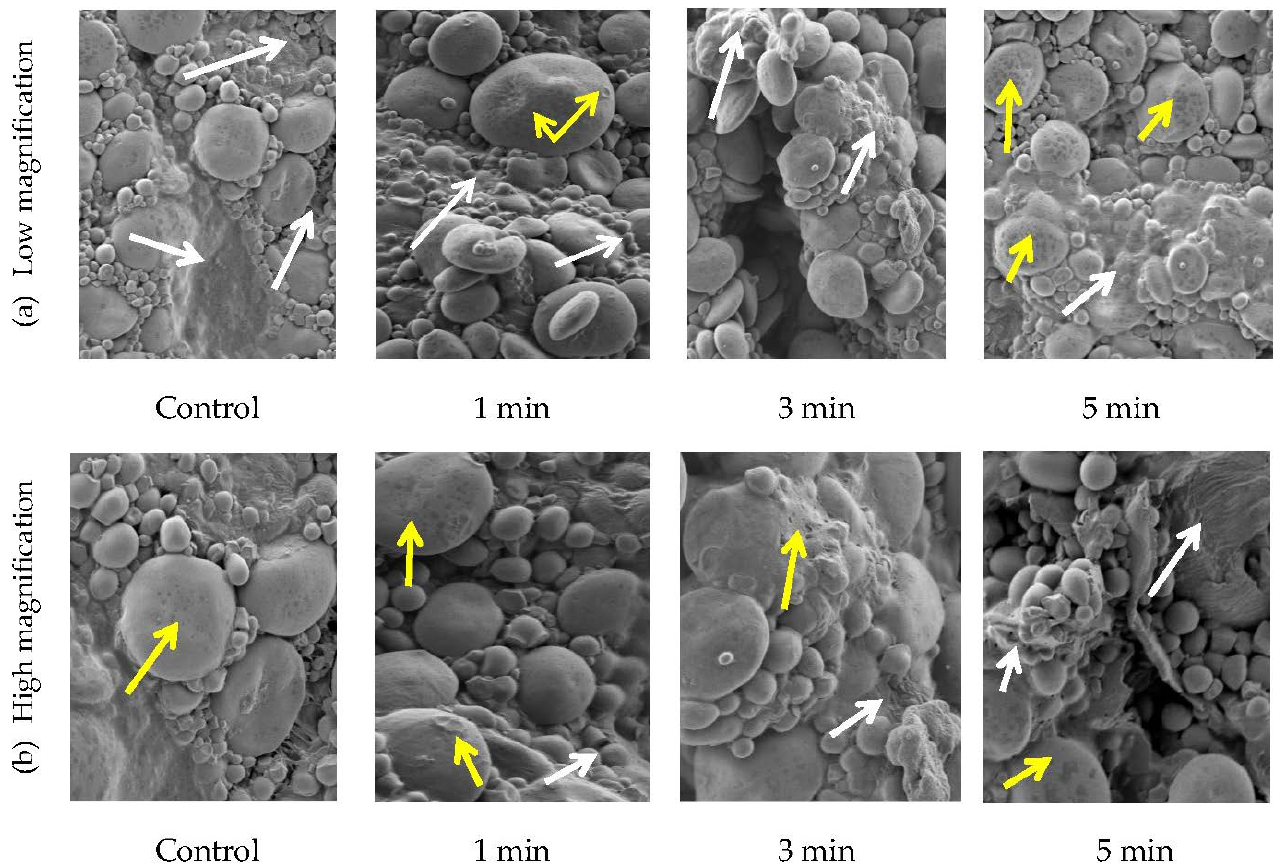
Figure 6. SEM Images of the wheat dough samples prepared with untreated and plasma-treated (1 min, 3 min, 5 min) flour under ( a ) low and ( b ) high magnifications (corresponding to 1000× and 2000× magnifications in the current SEM set-up). White arrows—gluten network; yellow arrows—changes to starch particles.